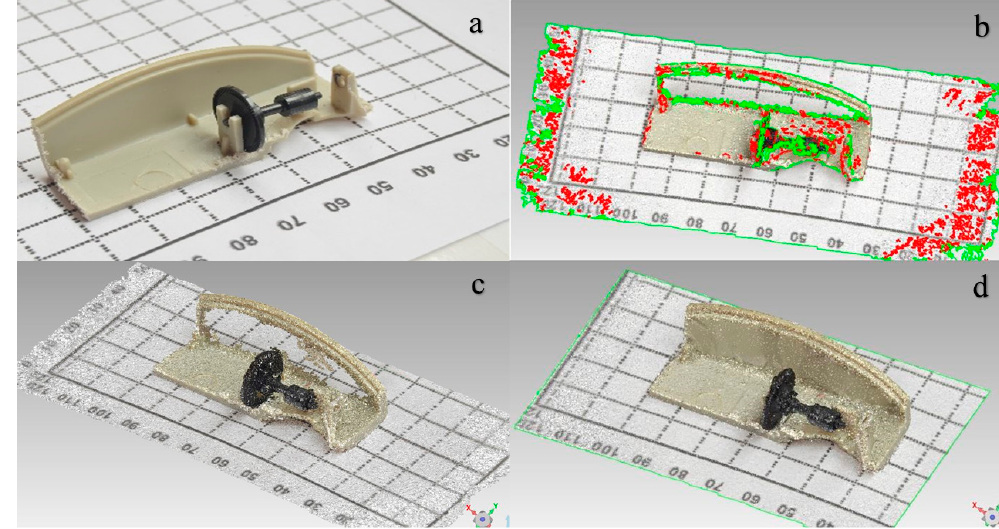
Figure 2. Images for photogrammetry process: ( a ) Real figure; ( b ) point cloud; ( c ) and ( d ) digital model.